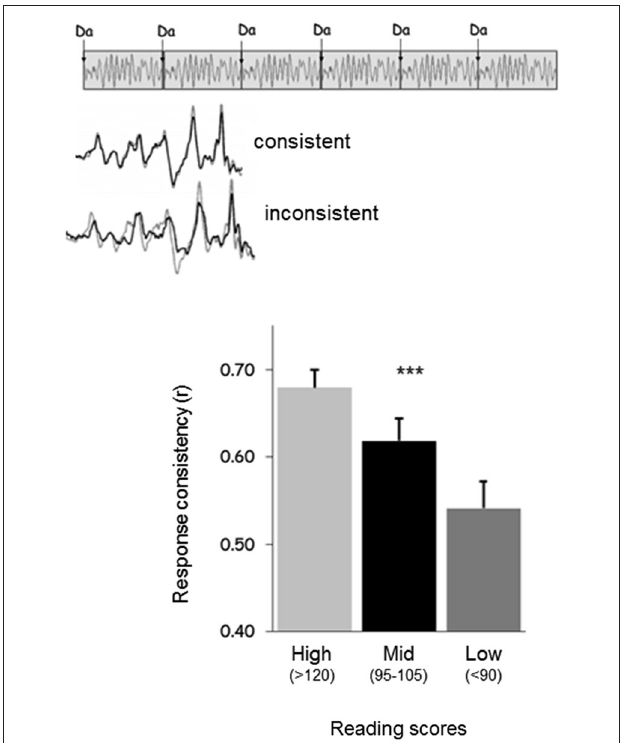
FIGURE 3 | (Top) Response consistency is a neural measure that assesses the extent to which the neural response to sound is consistent on a trial-by-trial basis across a recording. (Bottom) Good readers have responses with greater consistency than average readers, who have responses with greater consistency than poor readers (Hornickel and Kraus, 2013).